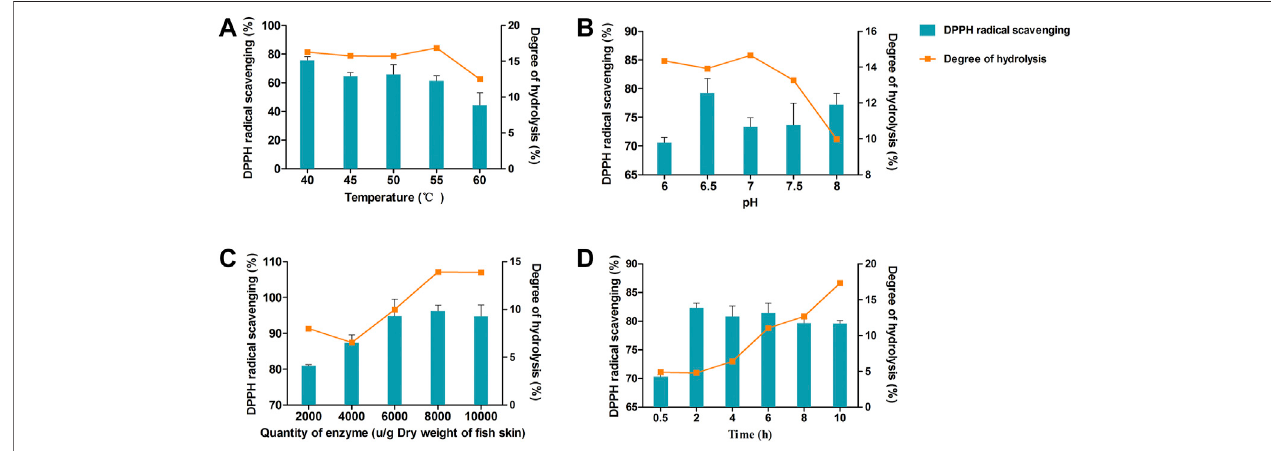
FIGURE 2 | DPPH clearance rate and degree of hydrolysis (DH) vary with hydrolysis temperature (A) , pH (B) , enzyme dosage (C) , and time (D) .